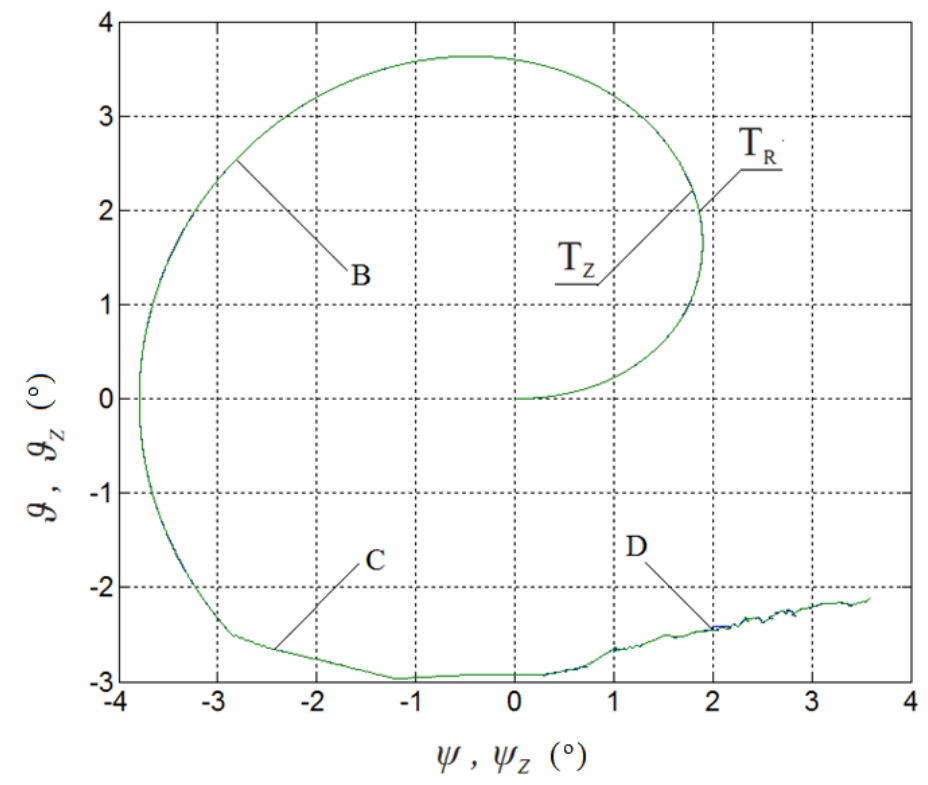
Figure 14. T Z set trajectory and pursued T R trajectory of the seeker axis in the airspace search phase and in the detected target tracking phase–modifiedLQR control.